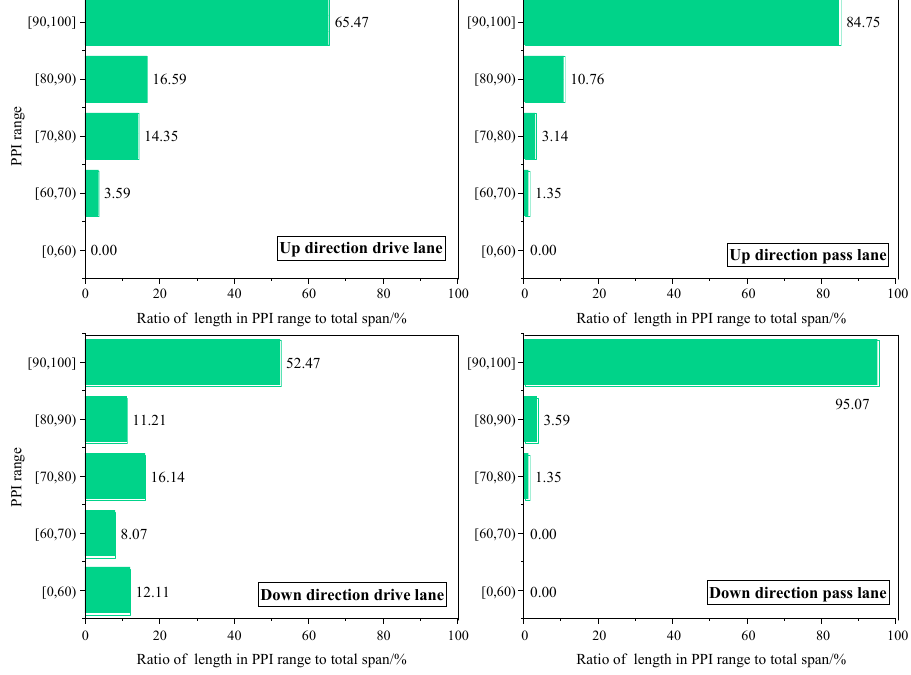
Figure 13. PPI distribution for the four lanes.